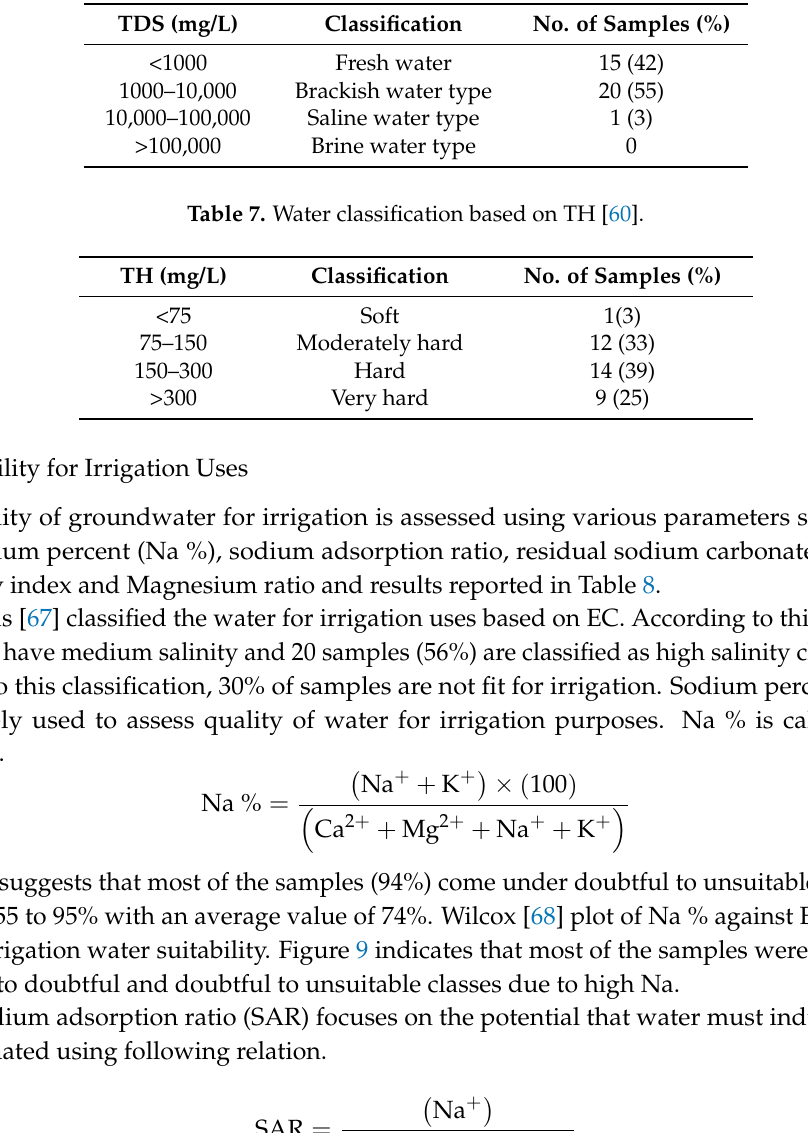
Table 6. Water classification based on TDS [44].